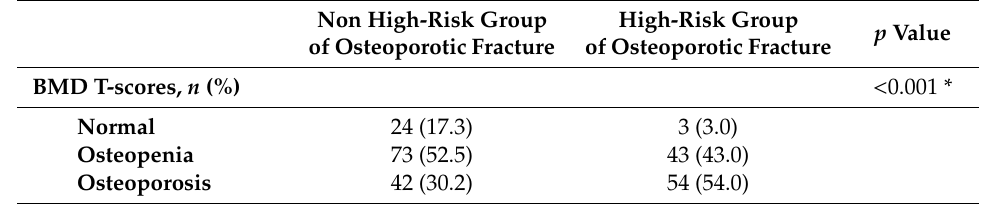
Table 7. Distributions of the BMD categories between the two groups based on the FRAX calculations with femur BMD T-scores in the patients with knee